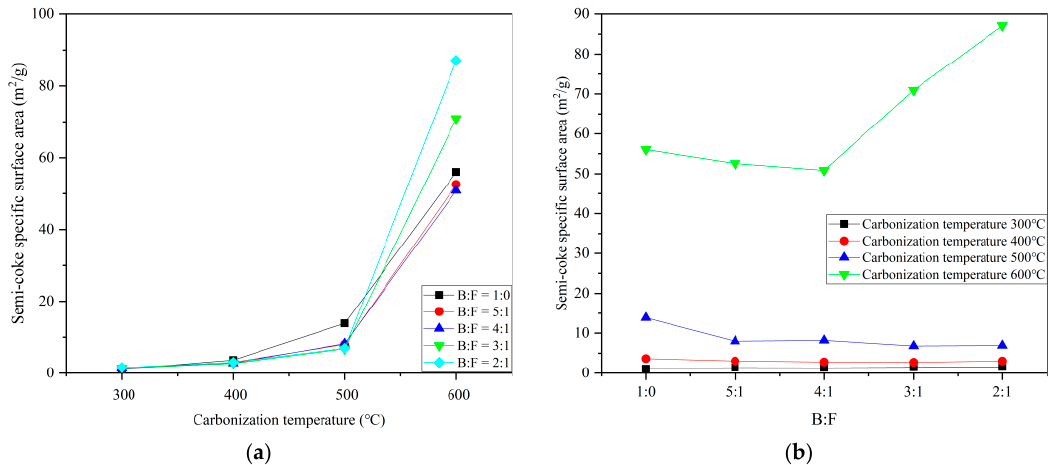
Figure 3. Variation trend of the specific surface area of semi-coke with respect to the carbonization temperature and mixing ratio of raw materials: ( a ) different carbonization temperatures and ( b ) different mixing ratios of raw materials. ( b ) different mixing ratios of raw